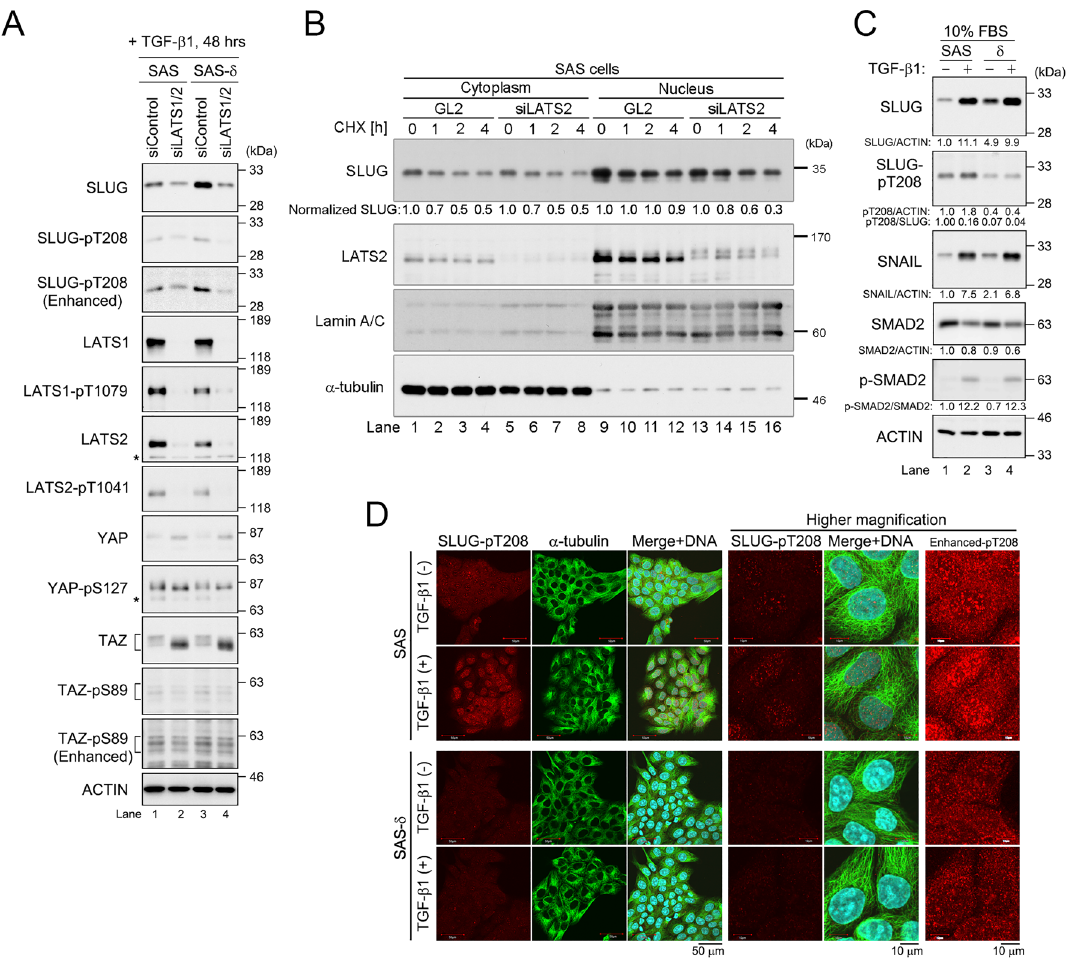
Figure 5. LATS1 and LATS2 phosphorylate SLUG on T208. ( A ) SAS and SAS-δ cells were co-transfected with siRNAs against LATS1 and LATS2 (siLATS1/2), and then cultured with TGF-β1 for 48 h, followed by WB with the indicated antibodies. ( B ) SAS cells transfected with GL2 (as a negative control) or LATS2 siRNA duplex were treated with cycloheximide (CHX) for the indicated periods, and then subjected to subcellular fractionation. Protein levels of SLUG and LATS2 were determined by WB. Lamin A/C and α-tubulin are nuclear and cytoplasmic fraction markers, respectively. The relative levels of cytoplasmic and nuclear SLUG normalized to the corresponding band intensities of α-tubulin and Lamin A/C, respectively, are shown below top panel. The normalized band intensities of SLUG at 0 h after CHX treatment were defined as 1.0 (lanes 1, 5, 9, and 13). ( C ) WB of parental SAS and SAS-δ, which were cultured in medium containing 10% FBS in the presence (+) or absence (–) of TGF-β1 (48 h), was performed with the indicated antibodies. The relative levels of the indicated proteins normalized to the corresponding band intensity of actin, SLUG, or SMAD2, are shown below panels. ( D ) Immunofluorescence staining with anti-SLUG-pT208 (red) and α-tubulin (green) antibodies. Cells were cultured as in ( C ). DNA was visualized by Hoechst 33258 staining (blue). The cell size were comparable between SAS and SAS-δ in the presence or absence of p-SAS and SAS-δ cells with TGF-β1 (Fig. 5C, lanes 2 and 4). The levels of SLUG-pT208 were significantly lower in SAS-δ than in p-SAS regardless of the presence of TGF-β1 (Fig. 5C, lanes 3 and 4), although the protein levels of SLUG were higher in SAS-δ and increased by the addition of TGF-β1, whereas p-SMAD2 level was compa- rable between p-SAS and SAS-δ. Indeed, immunofluorescence staining analyses also revealed that the nuclear accumulation of SLUG protein increased in SAS-δ after the addition of TGF-β1 (Fig. S4F, yellow arrows). On the other hand, SLUG-pT208 signals were localized both to the cytoplasm and the nucleus (in which the signals formed multiple dots) of p-SAS cells (Fig. 5D, top panels). Notably, SLUG-pT208 signals accumulated in the nucleus after addition of TGF-β1 (Fig. 5D, second panels from top), whereas the nuclear signals were significantly lower in SAS-δ cells regardless of TGF-β1 addition (third and fourth panels from top). Taken together, these results suggest that LATS1/2 causes the phosphorylation and accumulation of nuclear SLUG-T208 in p-SAS in a TGF-β1-dependent manner. This is supported by the observation that the level of SLUG-pT208 in SAS-δ expressing low levels of LATS1/2 was lower.